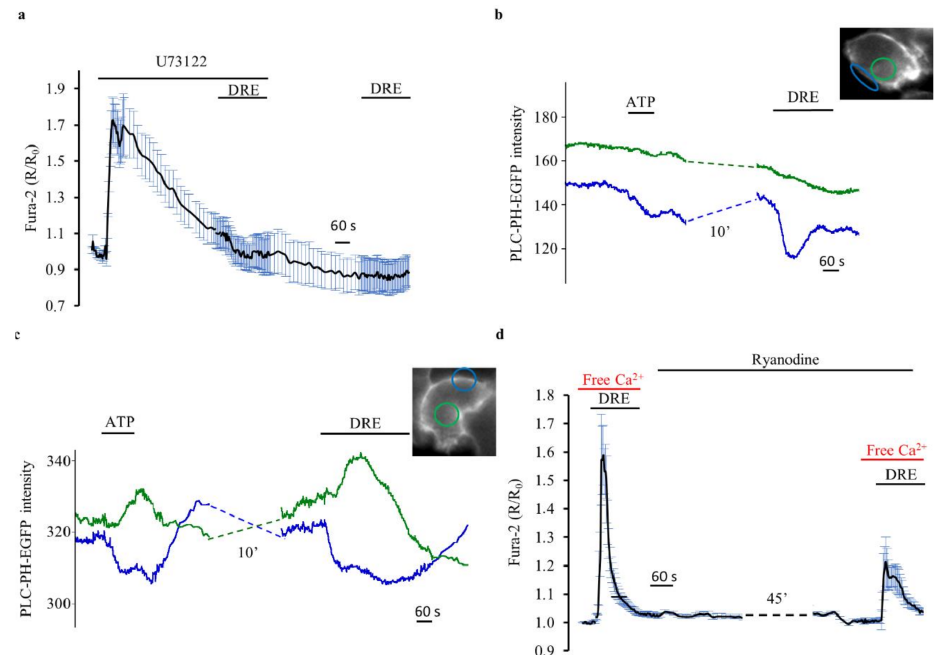
Figure 7. DRE exposure activates the downstream signaling effector phospholipase C. ( a ) Response of Fura-2-loaded HEK293 cells to DRE (400 µ g/mL) in the presence of or after exposure to U73122 (10 µ M). The reported values are means ± SE from all the responsive cells on a single coverslip. ( b , c ) Representative traces of the measurement of PLC activation in response to ATP and DRE, as measured by translocation of PH–PLC δ –EGFP from the plasma membrane (blue trace) to the cytosol (green trace). Inset image: Fluorescence of a representative cell excited at 480 nm showing, at rest, PH–PLC δ –EGFP associated mostly at the plasma membrane (blue ROI) but also weakly present in the peripheral cytoplasm (green ROI). ( d ) Response of Fura-2-loaded HEK293 cells to DRE (400 µ g/mL) in extracellular Ca 2+ -free solution before and after a prolonged (about 50 min) exposure to 100 µ M Ryanodine. The reported values are means ± SE from all the responsive cells on a single